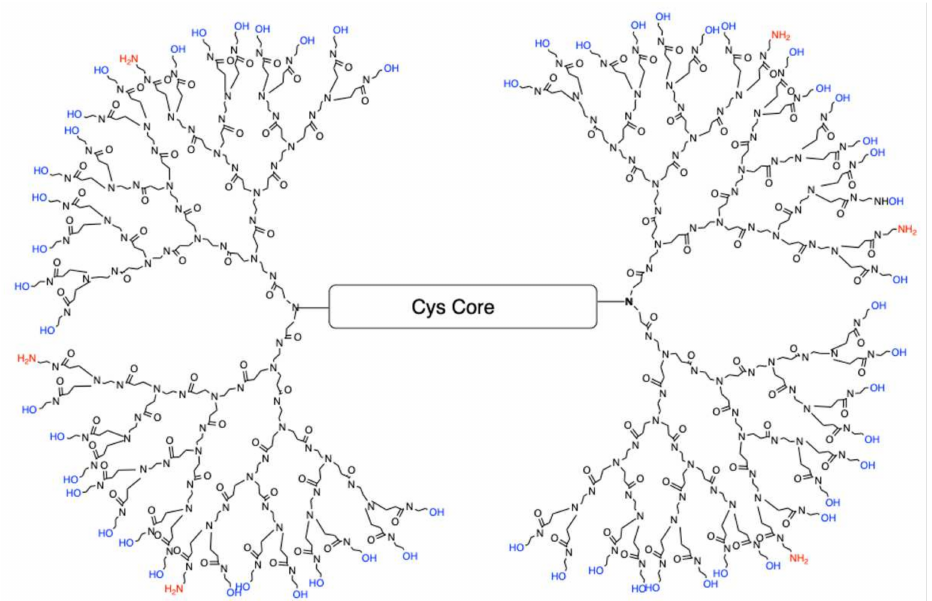
Figure 1. Configuration of G4 90/10-Cys in which 90% of the surface groups are –OH (blue), leaving only 10% as NH 2 (red). The core is cystamine.